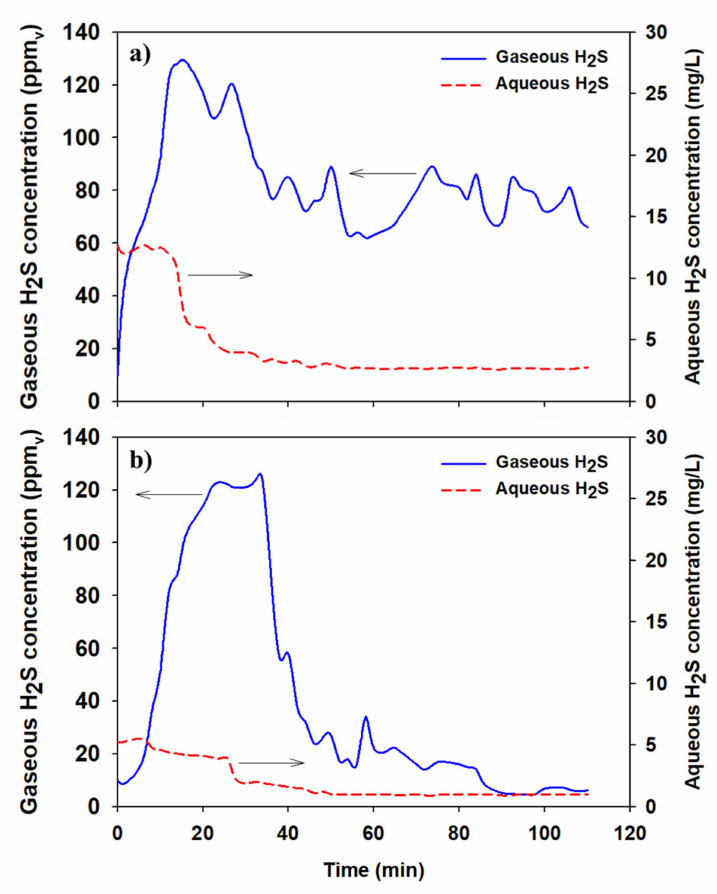
Figure 5. Concentration profiles of gaseous and aqueous H 2 S in ( a ) aeration without SOB and ( b ) aeration with SOB